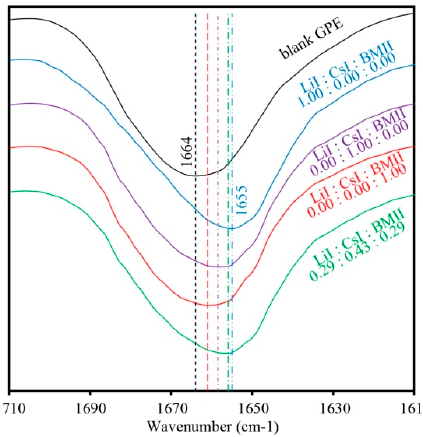
Figure 6. FTIR spectra of selected PhCh–(LiI:CsI:BMII) GPE samples for the amide absorption bands ranging from 1610 to 1710 cm − 1 .